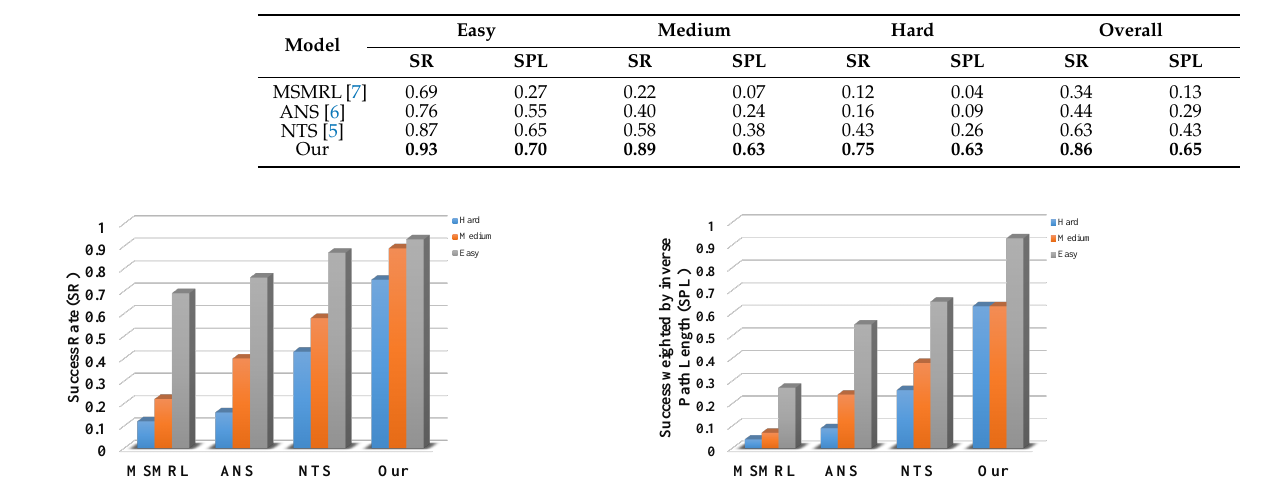
Table 1. Performance comparison results of the proposed algorithm with MSMRL, ANS, and NTS on the simulation datasets.